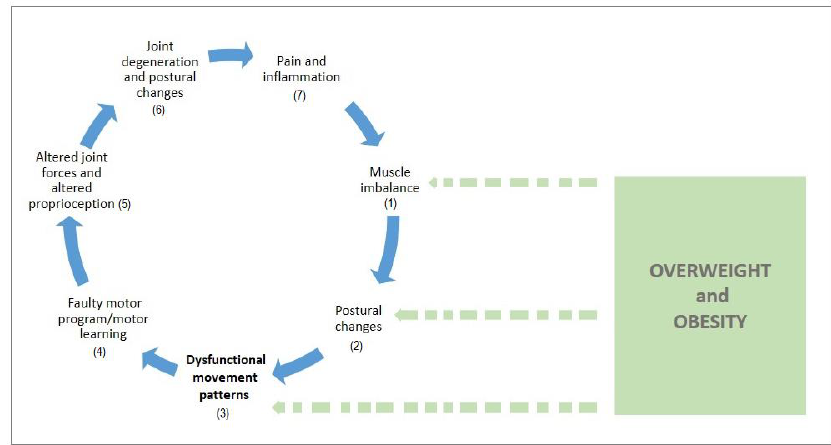
Figure 5. Model of musculoskeletal dysfunction cycle and contribution of obesity in the potential development of DFM patterns (modified according to Page et al., 2010).